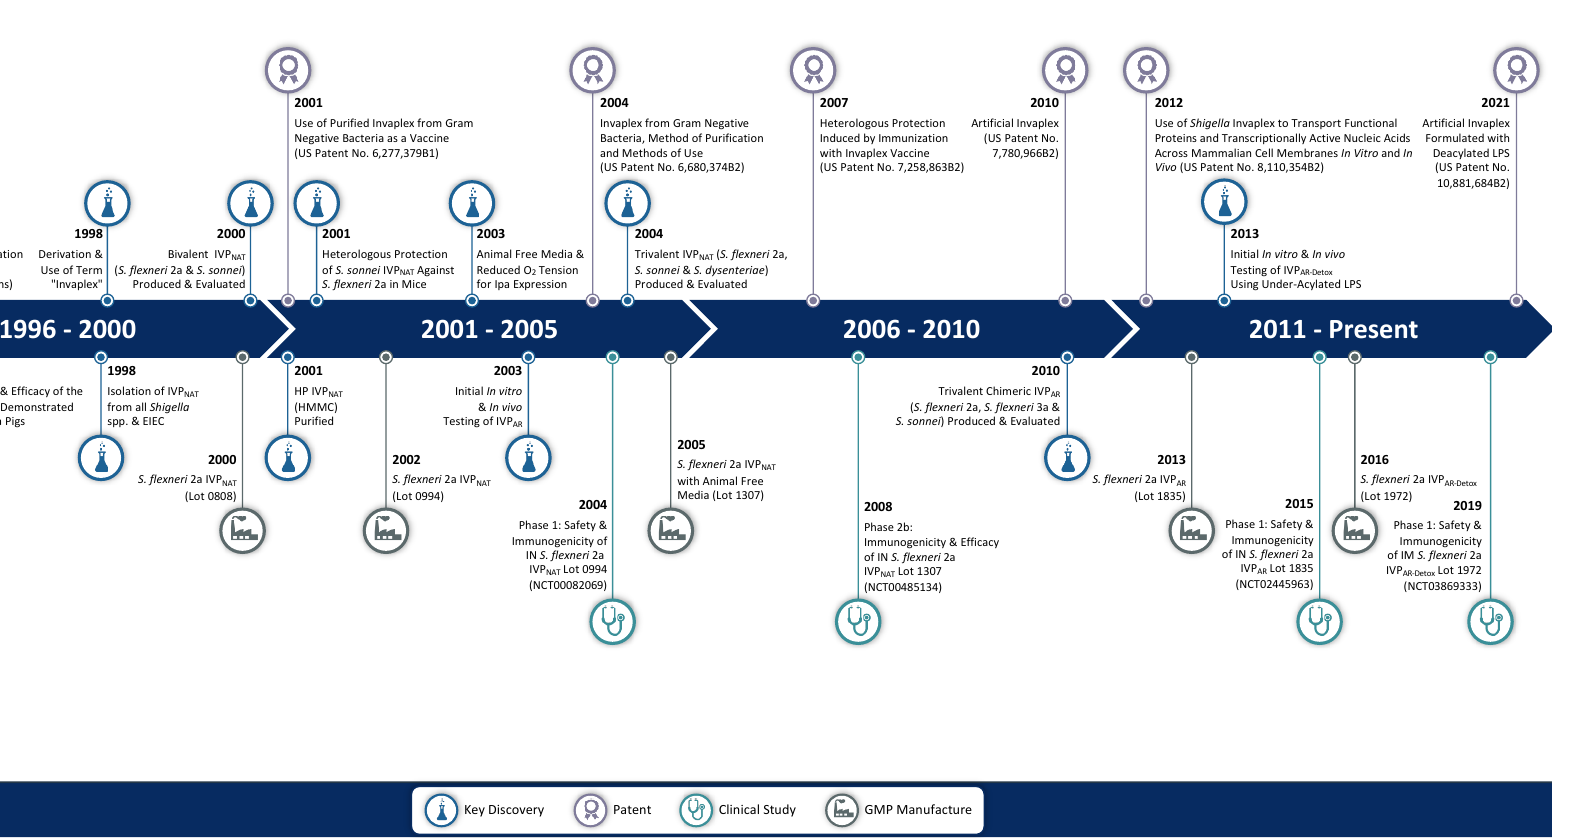
Figure 1. Milestones of Invaplex vaccine development: timeline of key discoveries, patents, cGMP manufactures, and clinical studies associated with the development and evolution of the Invaplex product.